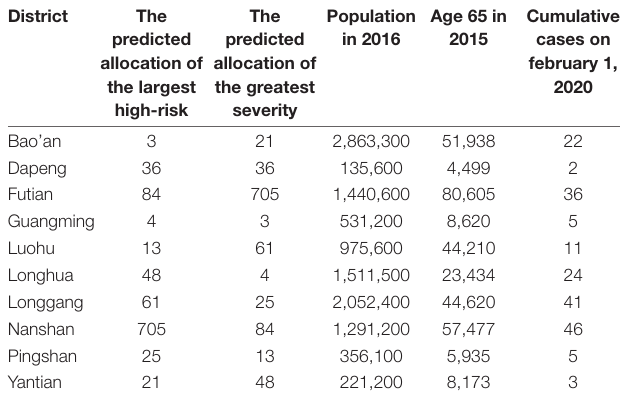
TABLE 2 | The demographic information of 10 districts in Shenzhen and the predicated PPE allocation of the highest risk and the greatest severity